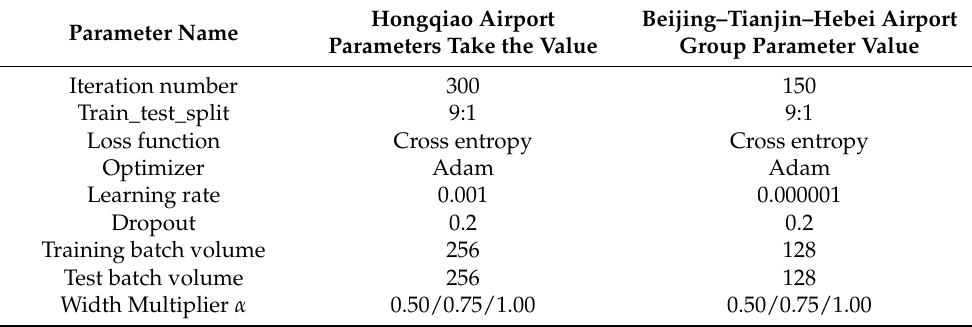
Table 3. Table of configuration of experimental